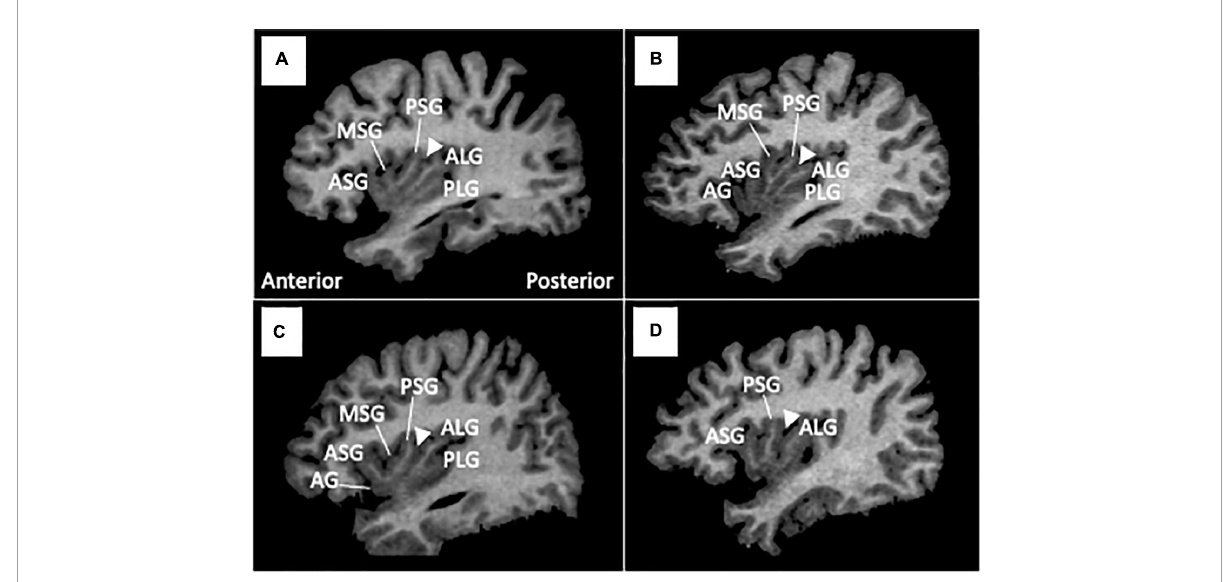
FIGURE1 Insular gross anatomical variations in sample MR images in sagittal views. Coronal and axial views were simultaneously referred to in assessments of gyral development. Arrowheads indicate the location of the central insular sulcus, which subdivides the short (anterior) and long (posterior) insular cortices. The ASG, PSG, and ALG were well-developed in all participants in this study, while the AG and MSG were absent [subject (D) ], underdeveloped [subject (C) ], or well-developed [subject (B) ]. The PLG was present in most subjects (A–C) , but was not observed in subject (D) . AG, accessory gyrus; ALG, anterior long gyrus; ASG, anterior short gyrus; MSG, middle short gyrus, PLS, posterior long gyrus; PSG, posterior short